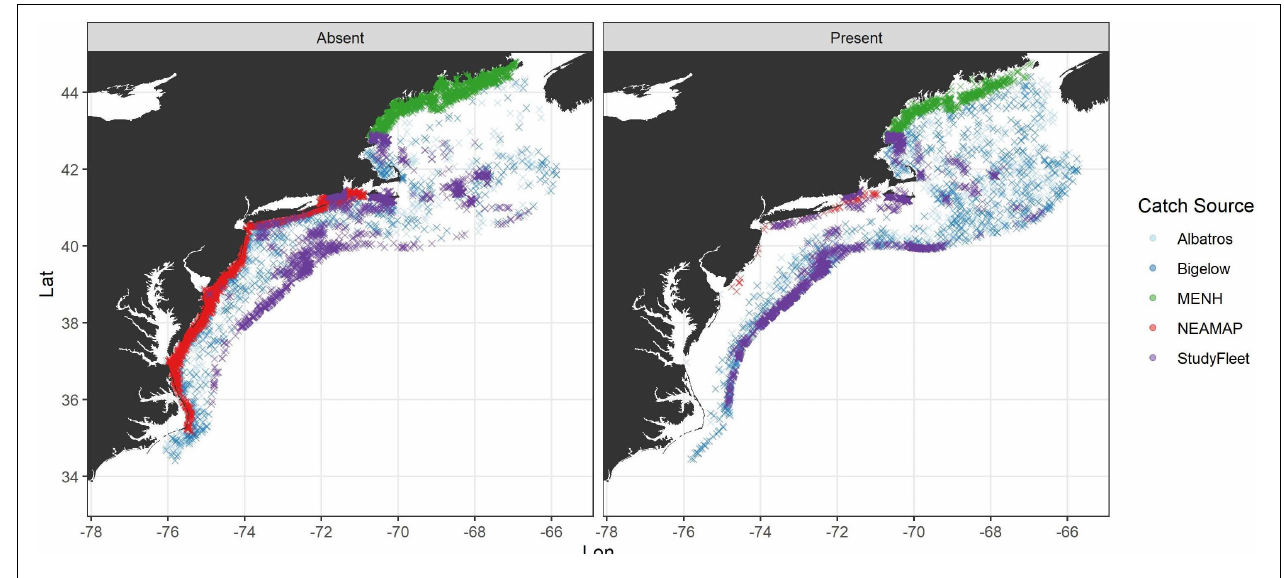
FIGURE 2 | Map of fishery-independent surveys [bottom trawls conducted by the Northeast Fishery Science Center (NEFSC), Northeast Area Monitoring and Assessment Program (NEAMAP), and the Maine Department of Marine Resources and New Hampshire Fish and Game Department (MENH)] and Study Fleet coverage 2000–2018. Data from the two research vessels (Albatros and Bigelow) that have been used in the NEFSC bottom trawl are shown